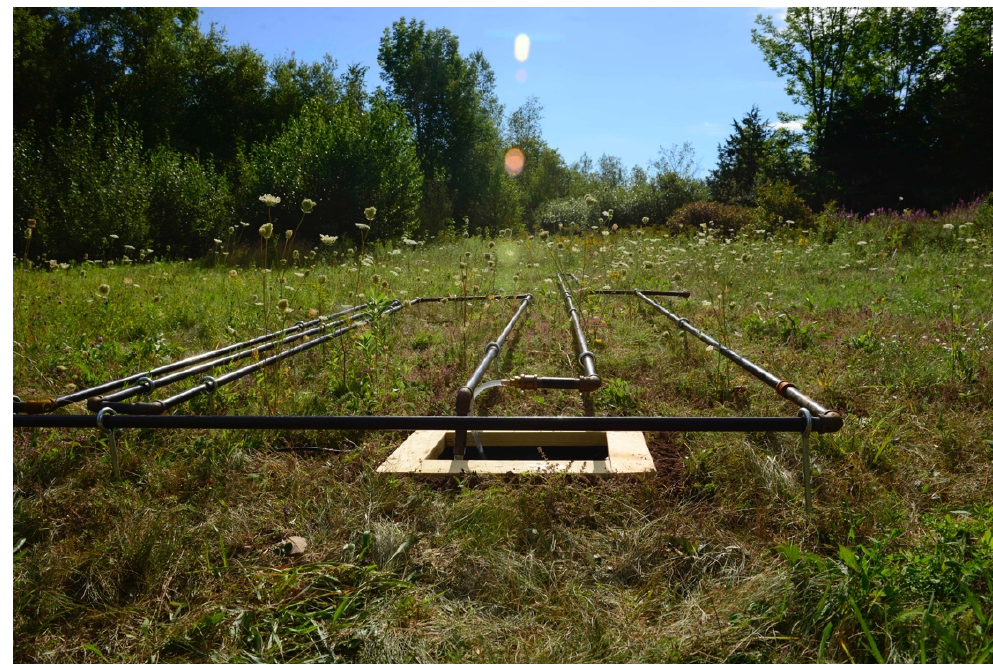
Figure 4: Cloud Point: A Derivative of Crude Illumination by Elia Vargas , a crude oil pipeline and sonic feedback installation, created and exhibited at Wave Farm Transmission Arts, Acra, New York, 2016. Photo: Elia